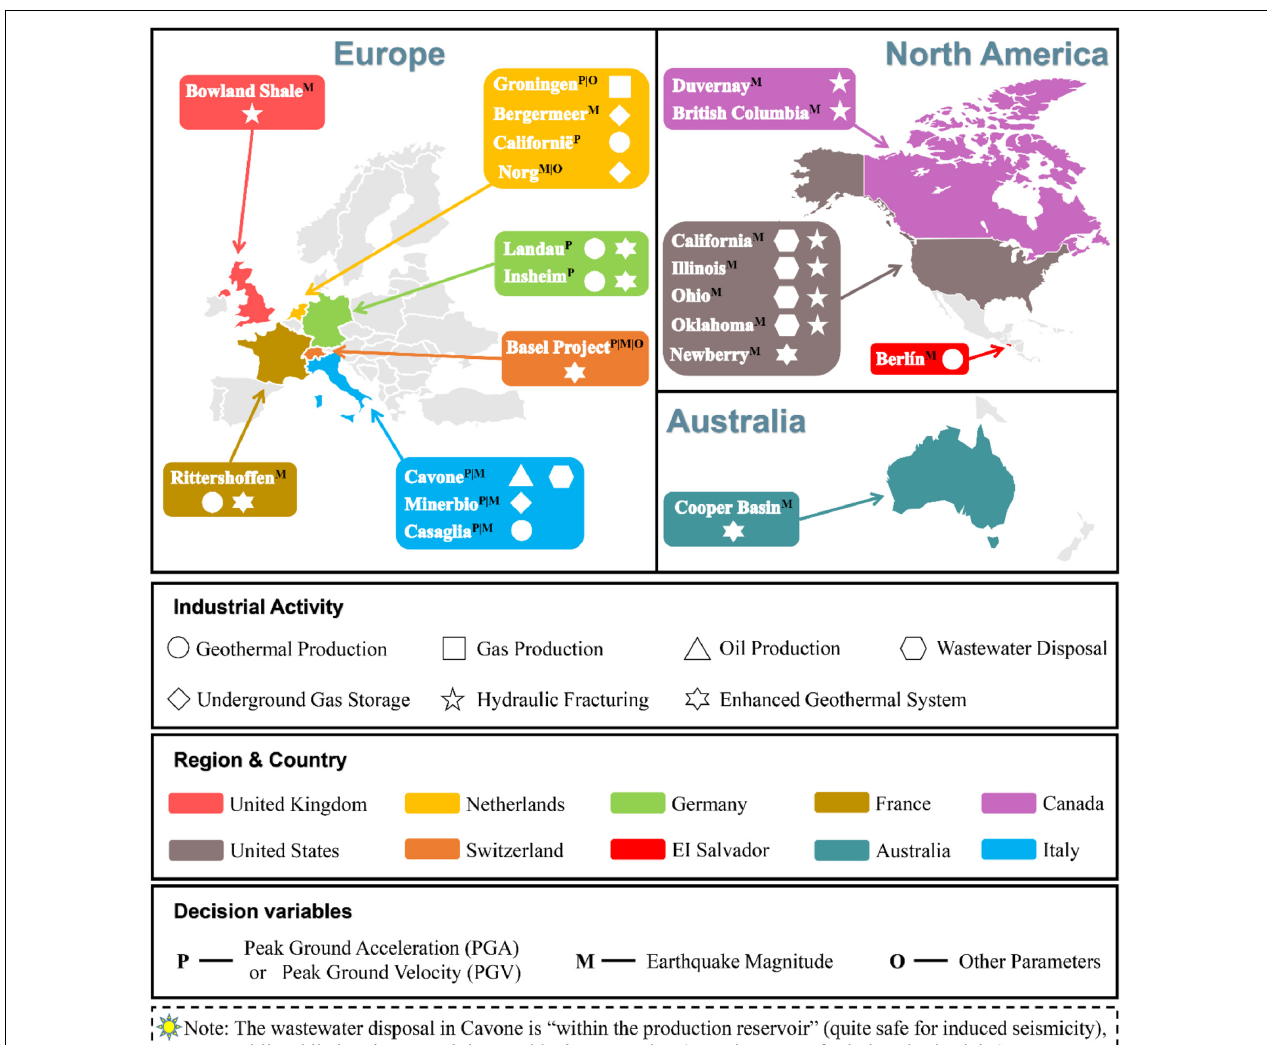
FIGURE 4 | Application cases of traffic light system (TLS) corresponding to different industrial activities in Europe, North America and